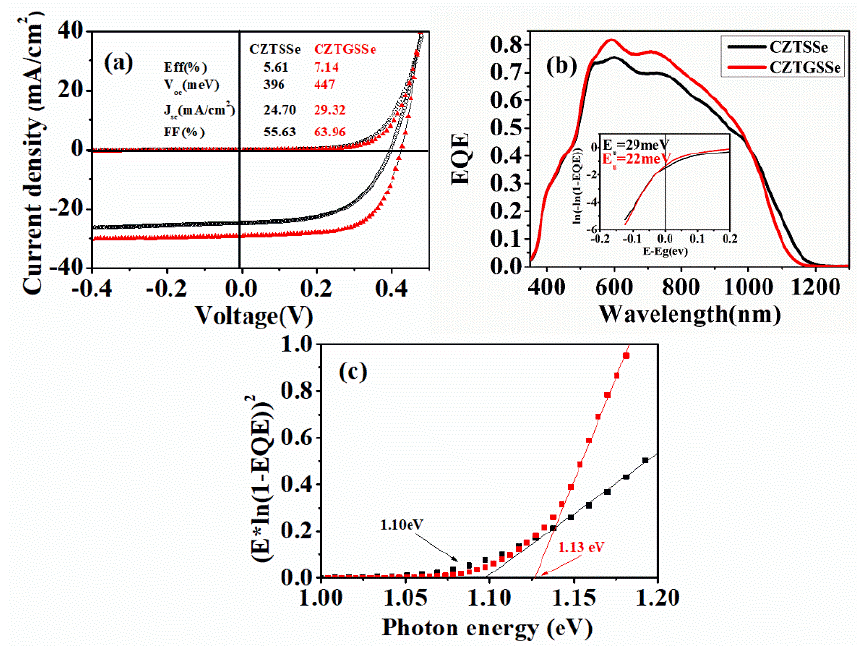
Figure 5. ( a ) J–V curve; ( b ) external quantum efficiency (EQE); and ( c ) band-gap estimation for CZTSSe and CZTGSSe solar